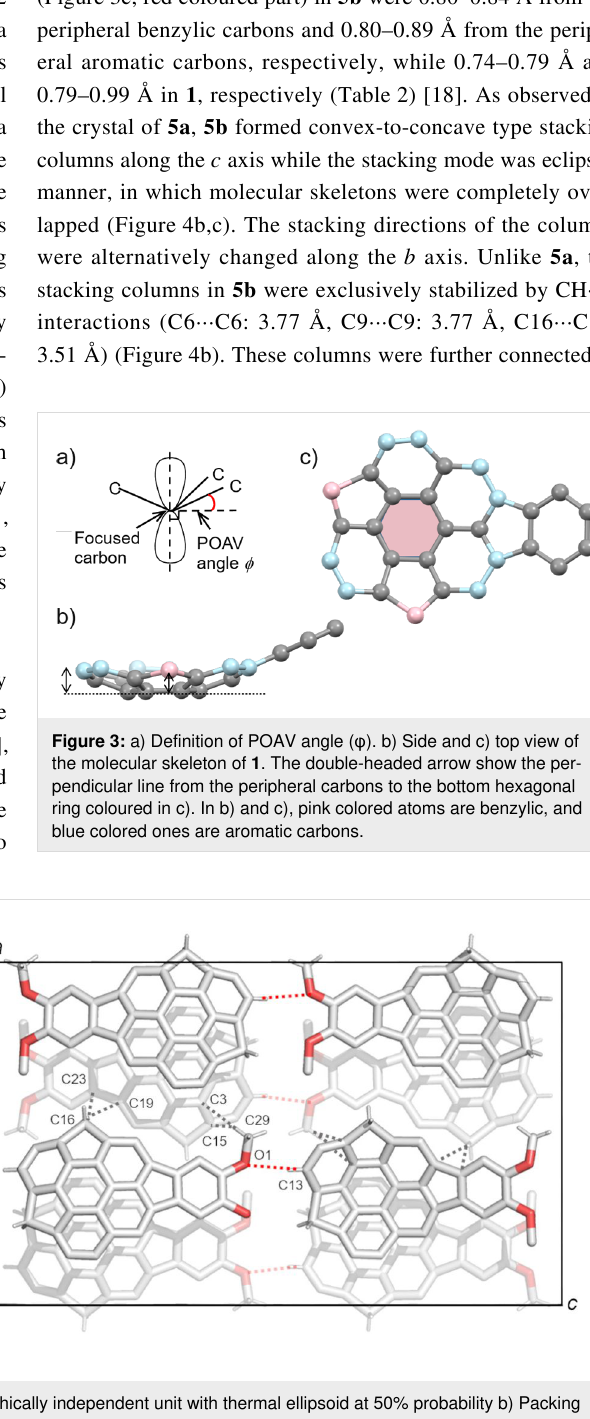
Figure 2: Crystal structure of 5a . a) ORTEP drawing of the crystallographically independent unit with thermal ellipsoid at 50% probability b) Packing structure viewed from the a axis and c) from the b axis. The dotted lines indicate; blue: π – π , grey: CH··· π , red: CH···O interactions. In b) and c), hydro- gen atoms which are not engaged in any interactions are omitted for clarity.